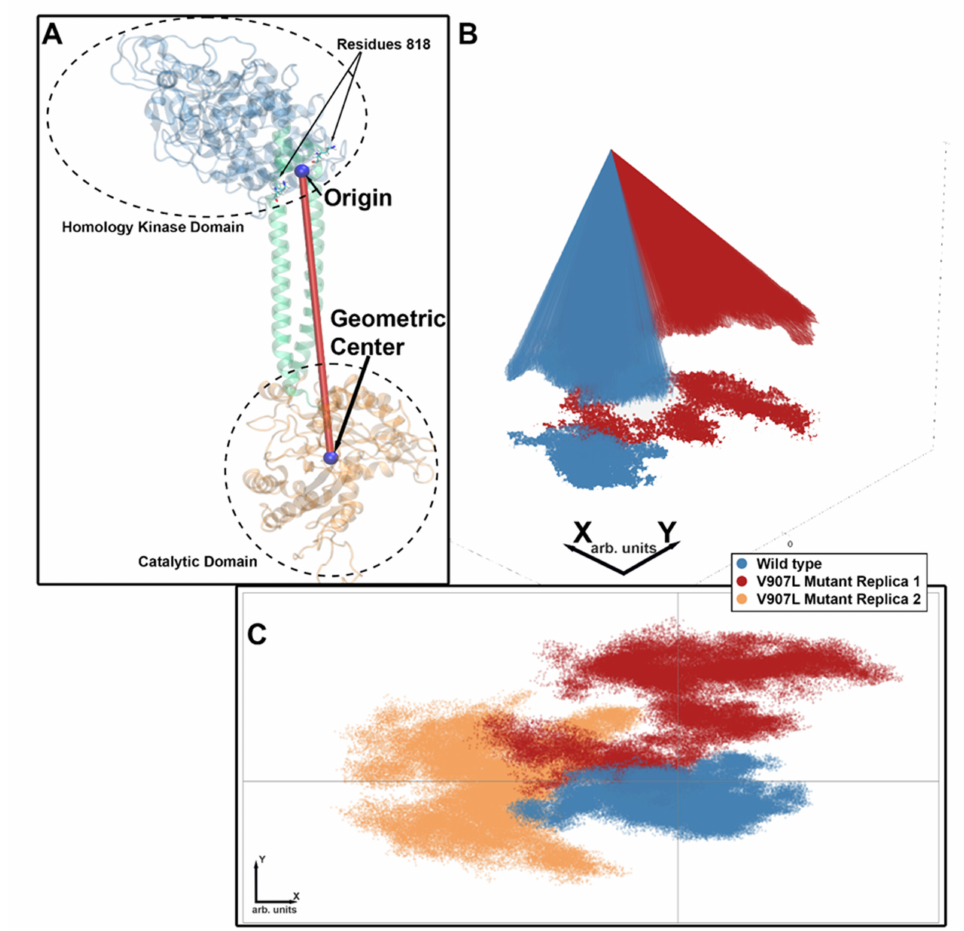
Figure 5. Visualization of bovine GC-E orientation through the plane projection. ( A ) The two residues at position 818 in the GC-E dimer were located at the beginning of the alpha-helical dimerization domain (green). The protein structure was translated such that the origin (0,0,0) was just in the middle between the two residues 818 (measured from the first carbon in the backbone). For each MD snapshot, the line segment between the origin and the geometric center of the catalytic domain was considered as indicated by the red line in panel A. ( B) The endpoints of the line segments were then projected to the x–y plane. The projection describes the area in which the catalytic domain moved relative to the kinase homology domain during the simulation. ( C ) The last panel shows the top view of the projected area, including the results for both mutant replica simulations. It can be seen that the wild type remained in its original position, while both replicas moved away, although in different